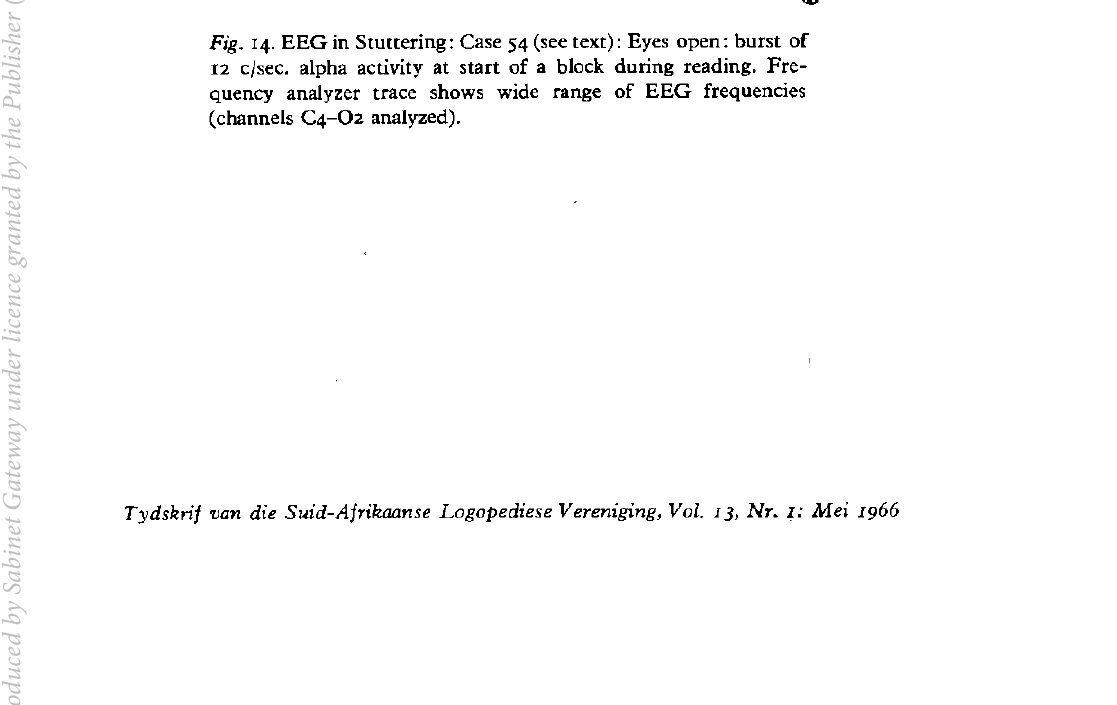
Fig. 14. EEG in Stuttering: Case 54 (see text): Eyes open: burst of 12 c/sec. alpha activity at start of a block during reading. Fre- quency analyzer trace shows wide range of EEG frequencies (channels C4-O2